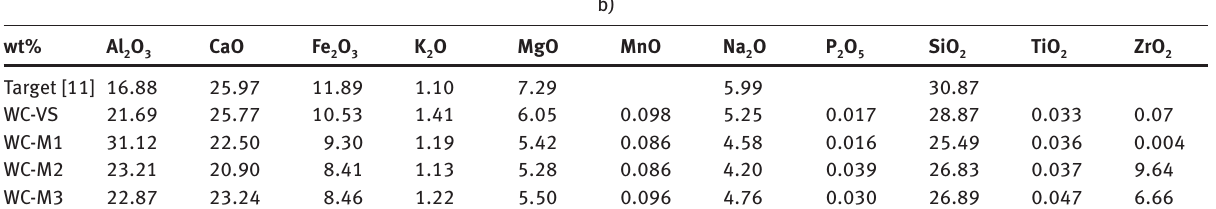
wt% Al 2 O 3 CaO Target [11] 26.50